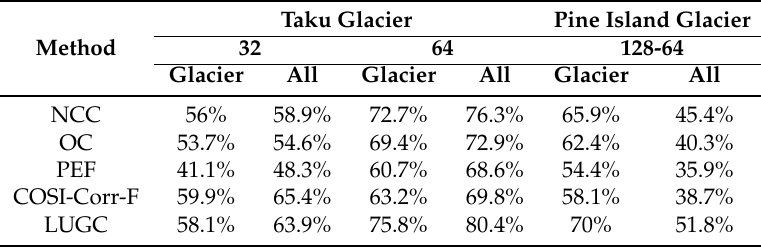
Table 4. RMSE and mean absolute error of the matching results of different matching methods. Taku Glacier Pine Island Glacier Method Glacier All Glacier